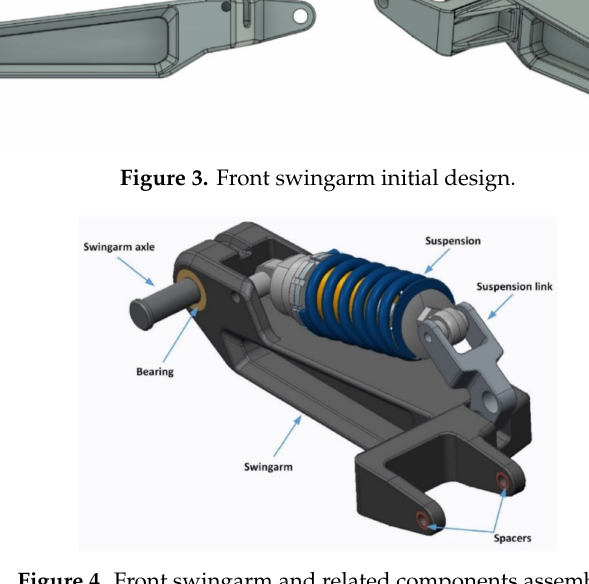
Figure 4. Front swingarm and related components